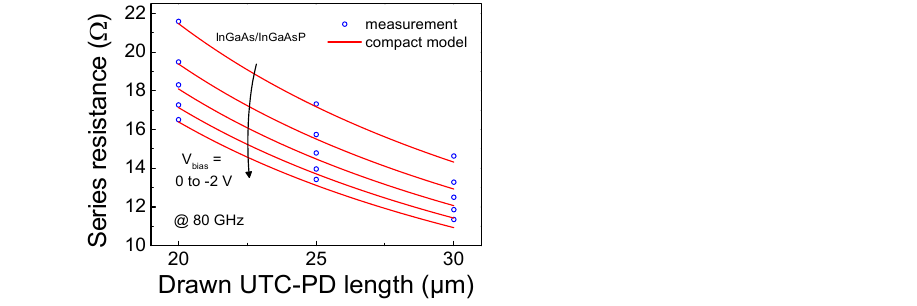
Figure 12. The extracted total series resistance at various reverse biases and for several lengths of the InGaAs/InGaAsP UTC-PDs.